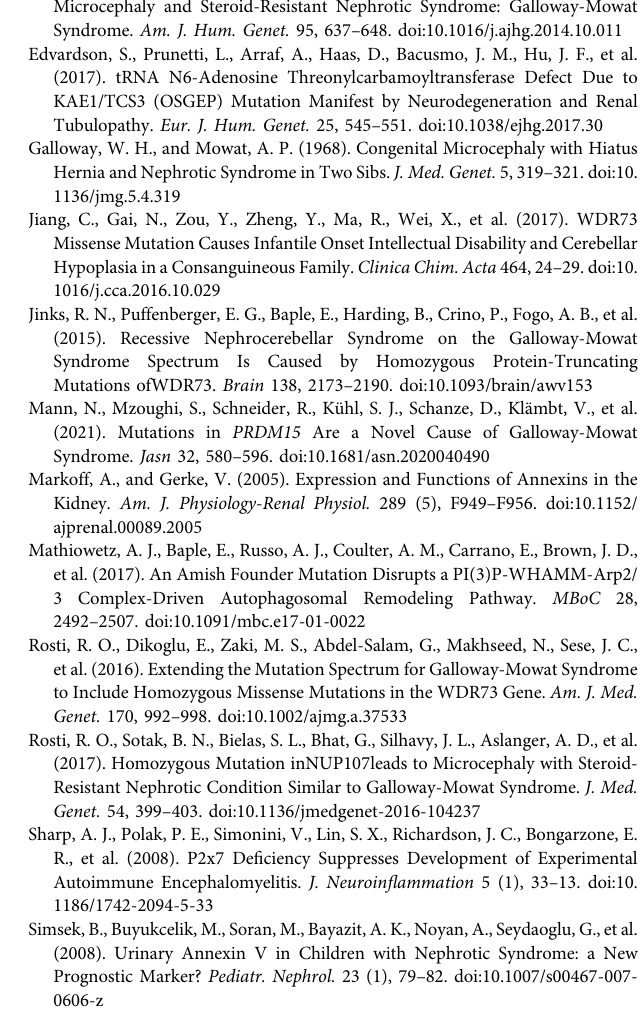
Supplementary Figure S1 | OSGEP protein 3D model. (A) Crystallized structure of the human probable tRNA N6-adenosine threonylcarbamoyltransferase (PDB accession number 6GWJ.1.C). (B,C) Protein structure is shown as teal ribbon, while the amino acids at the mutation site are displayed as red stick. The catalytic bindingsitesofOSGEParemappedasbluespheres(Residues:H109,H113,Y130, N266, G177, E181, N266, and D294). (D) Surface electrostatic potential surrounding Arg325, with the protruding positive patch generated by the arginine, which is lost in the bottom – right picture (E) after the replacement for glycine. The amino acid substituted from large-sized arginine (hydrophilic, positively charged) to smaller-sized glycine (hydrophobic, neutral) at position 325 which is close by the main catalytic active sides of OSGEP and predicted to affect its interaction with tRNA. Supplementary Figure S2 | PCA plot of the two fi rst principal components. Supplementary Figure S3 | Expression pro fi les. Supplementary Figure S4 | Top canonical pathways. Supplementary Figure S5 | Comparative depiction of location and function. SupplementaryFigureS6| Toppathwaysofgenesofthedownregulatedproteins. Supplementary Figure S7 | Top pathways of genes of the upregulated